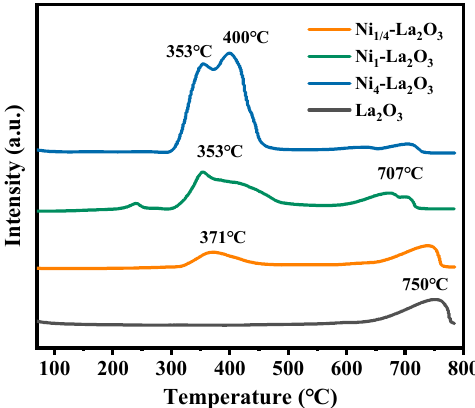
Figure 3. H 2 -TPR profiles of oxide precursors of Ni x -La 2 O 3 catalysts.